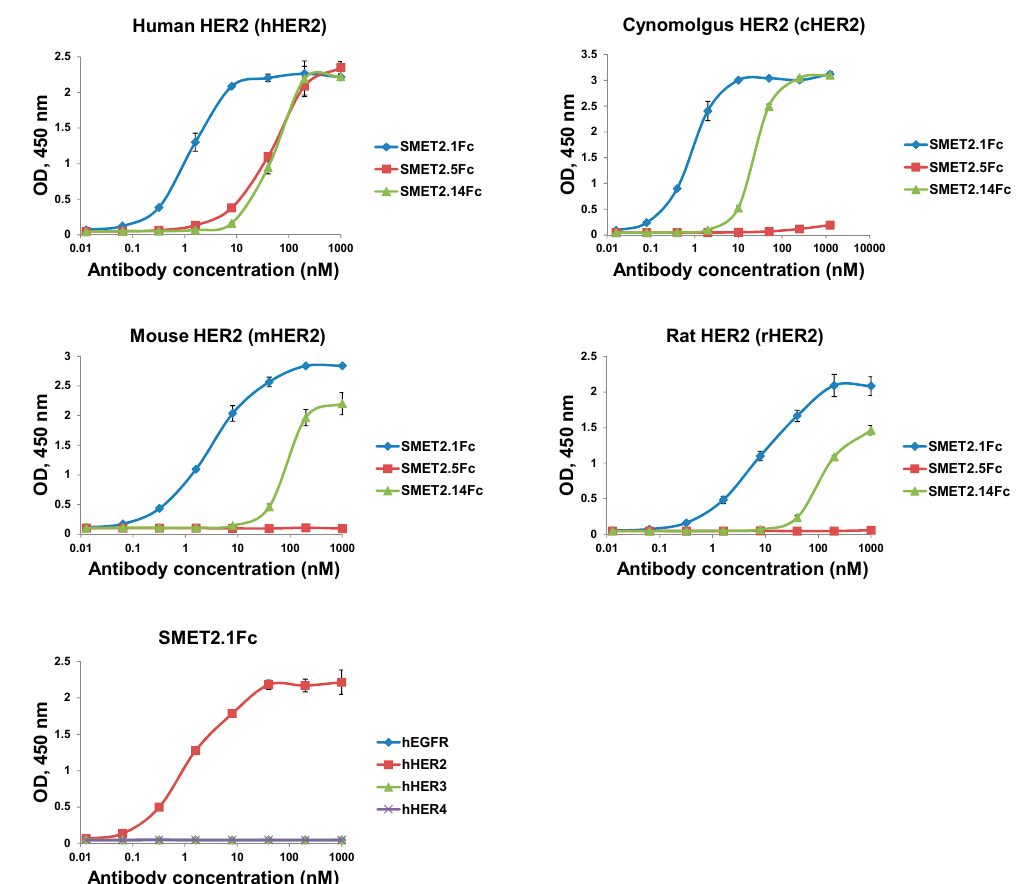
Figure 3. ELISA binding of the dAb-Fc fusion proteins to recombinant HER2 proteins from different species or different human ErbB family member proteins. Recombinant antigens were coated on 96-well plates at a concentration of 2 µ g mL − 1 . Bound Fc-fusion proteins were detected by HRP-conjugated goat anti-human IgG (Fc-specific) antibody. The assay was performed in duplicate. Results are the mean ± standard deviation.